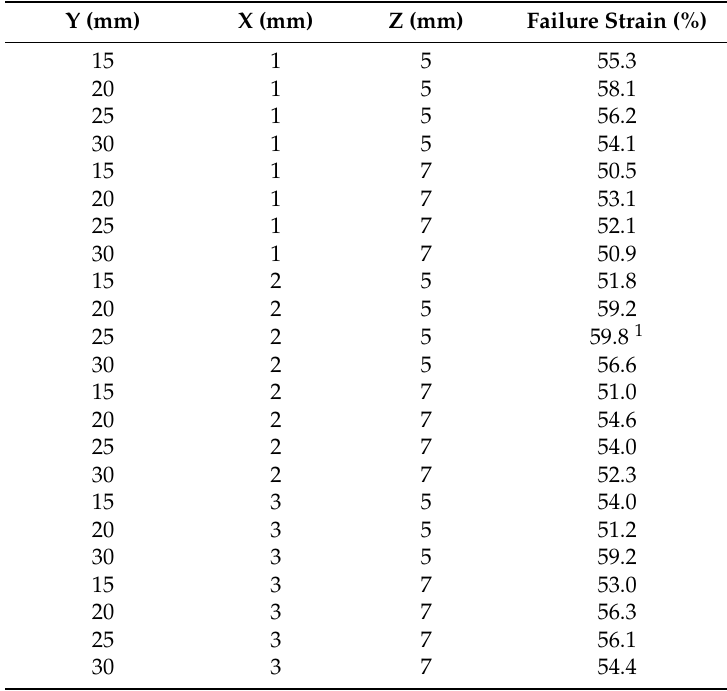
Figure 4. The failure zone on the conductive track after the critical plastic strain (PE) limit. Table 1. Finite element (FE) analysis results for different encapsulation layer geometric parameters (see Figure 2).